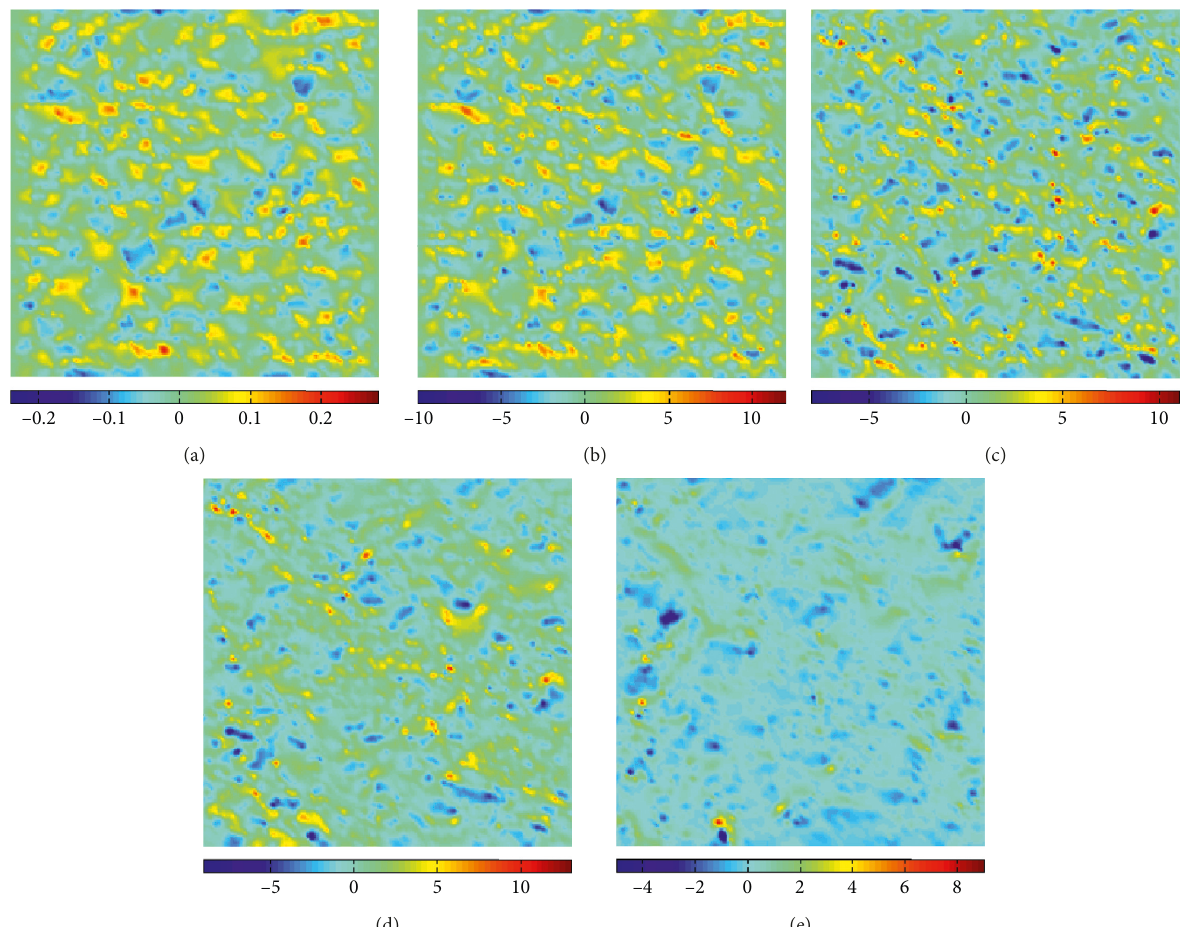
Figure 16: Failure process of the maximum principal stress contour plots under uniaxial compression.